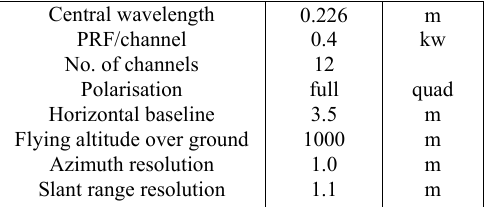
Figure 2a: Tomogram along Azimuth (1)